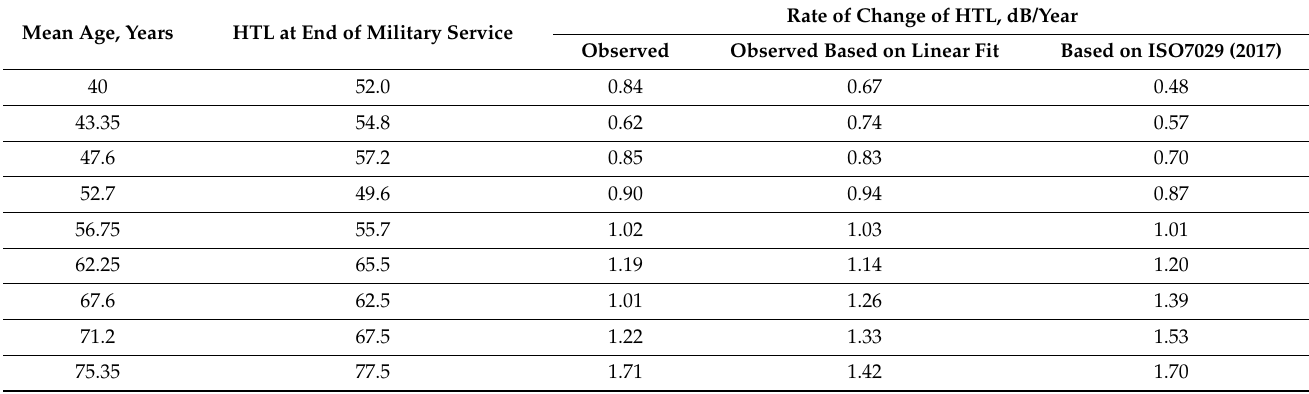
Table 4. As Table 2, but for the left ear at 4 kHz.